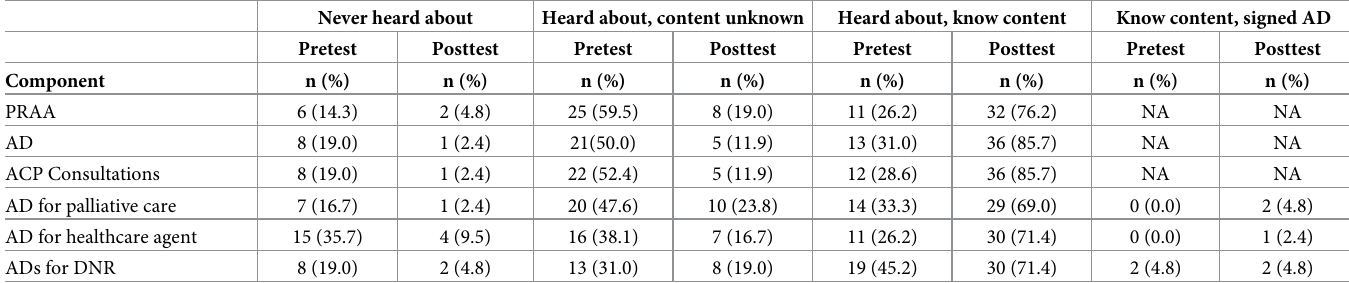
Table 4. Familiarity with components of ACP for FCGs (n = 42), pre-intervention (pretest) and post-intervention